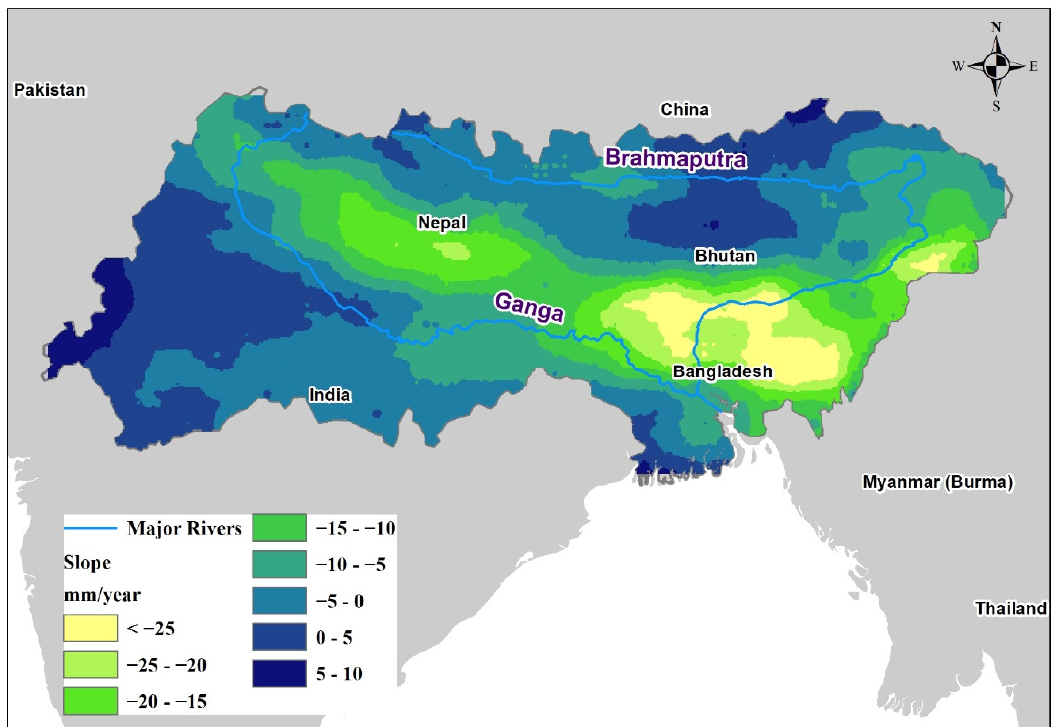
Figure 3. Trend of annual precipitation in GB basin.